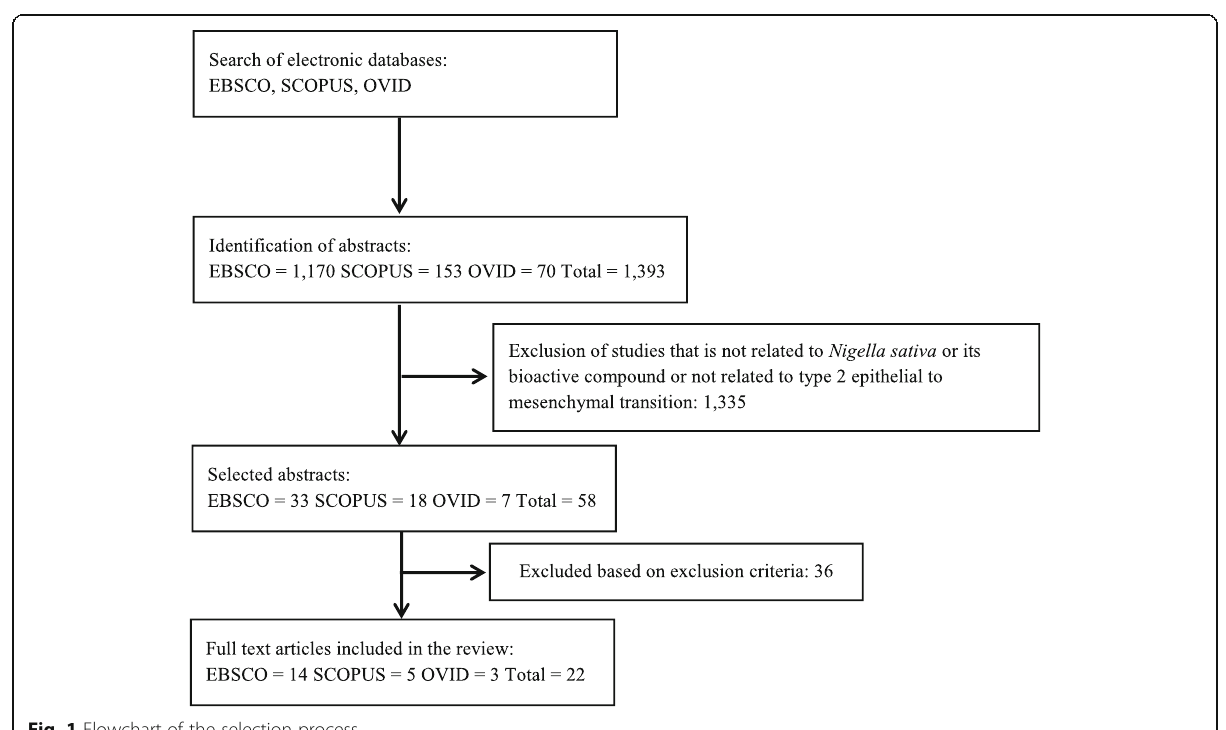
Potential of Nigella sativa and thymoquinone in wound healing Cutaneous normal wound